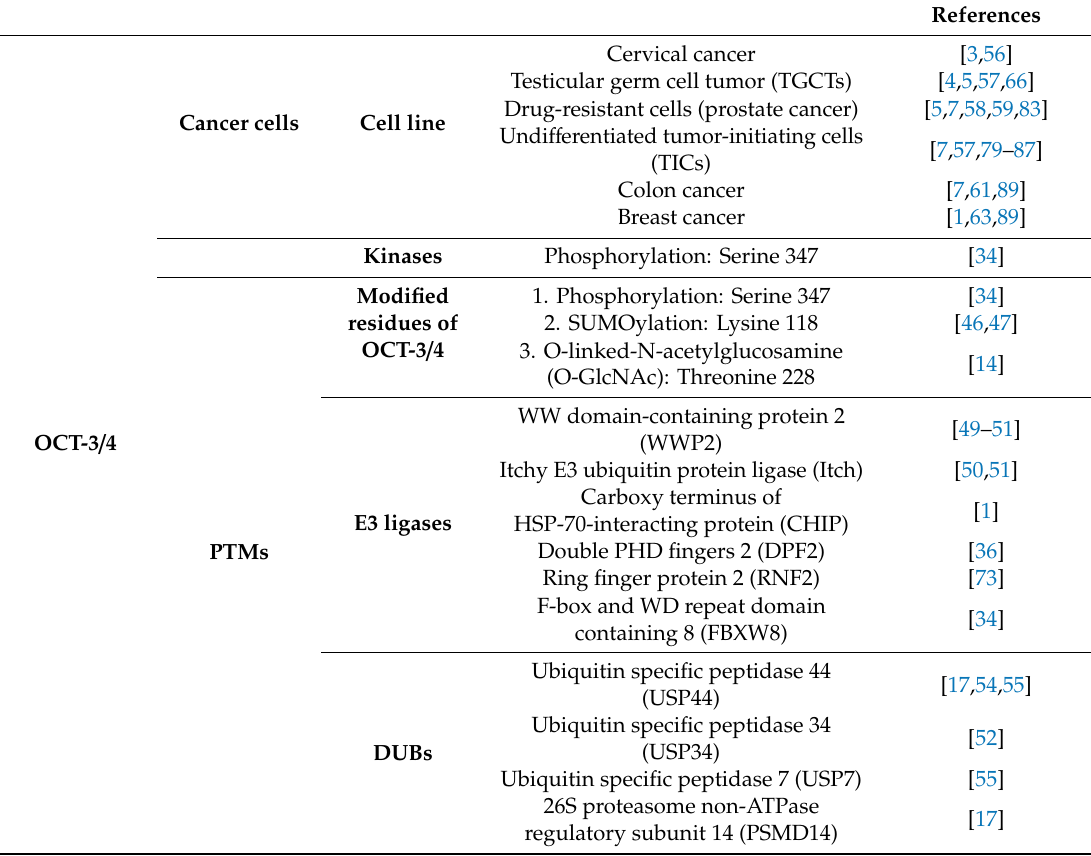
Table 1. PTMs of OCT-3 / 4, and E3 ligases and DUBs regulating OCT-3 /